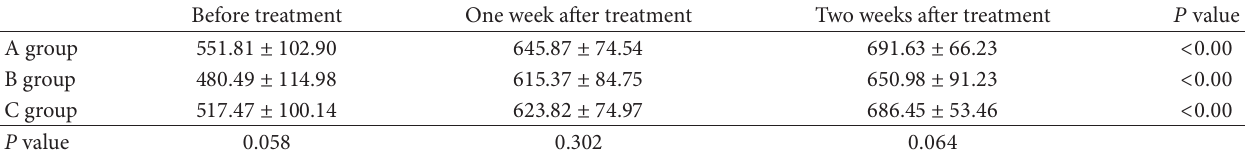
Table 2: Comparisons of SF-36 scores before and one and two weeks after the treatment.